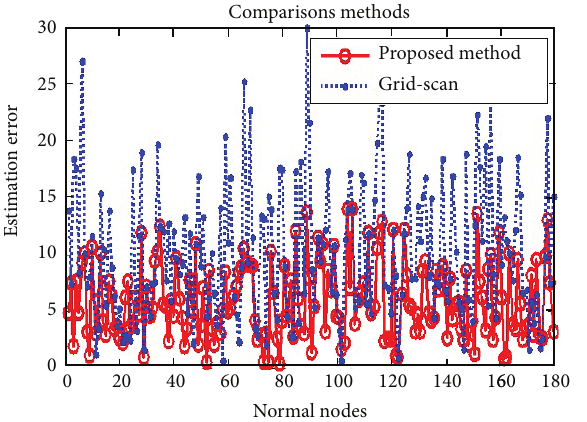
Figure 2: Normal node versus estimation error.